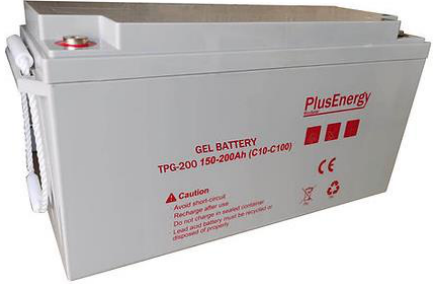
Figure 2. PlusEnergy Gel Battery TPG 12 V 150–200 Ah (C10–C100).